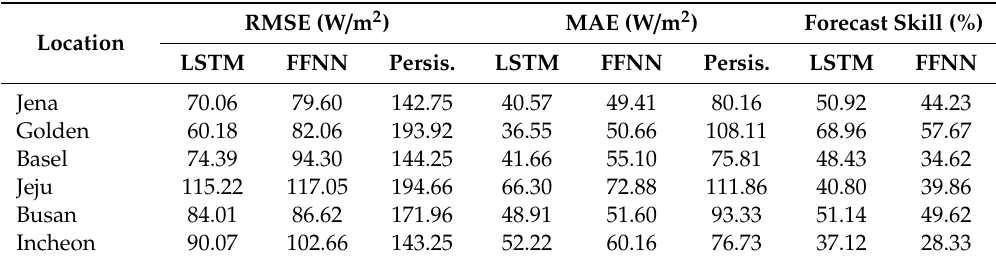
Table 7. Performance evaluation of NARX